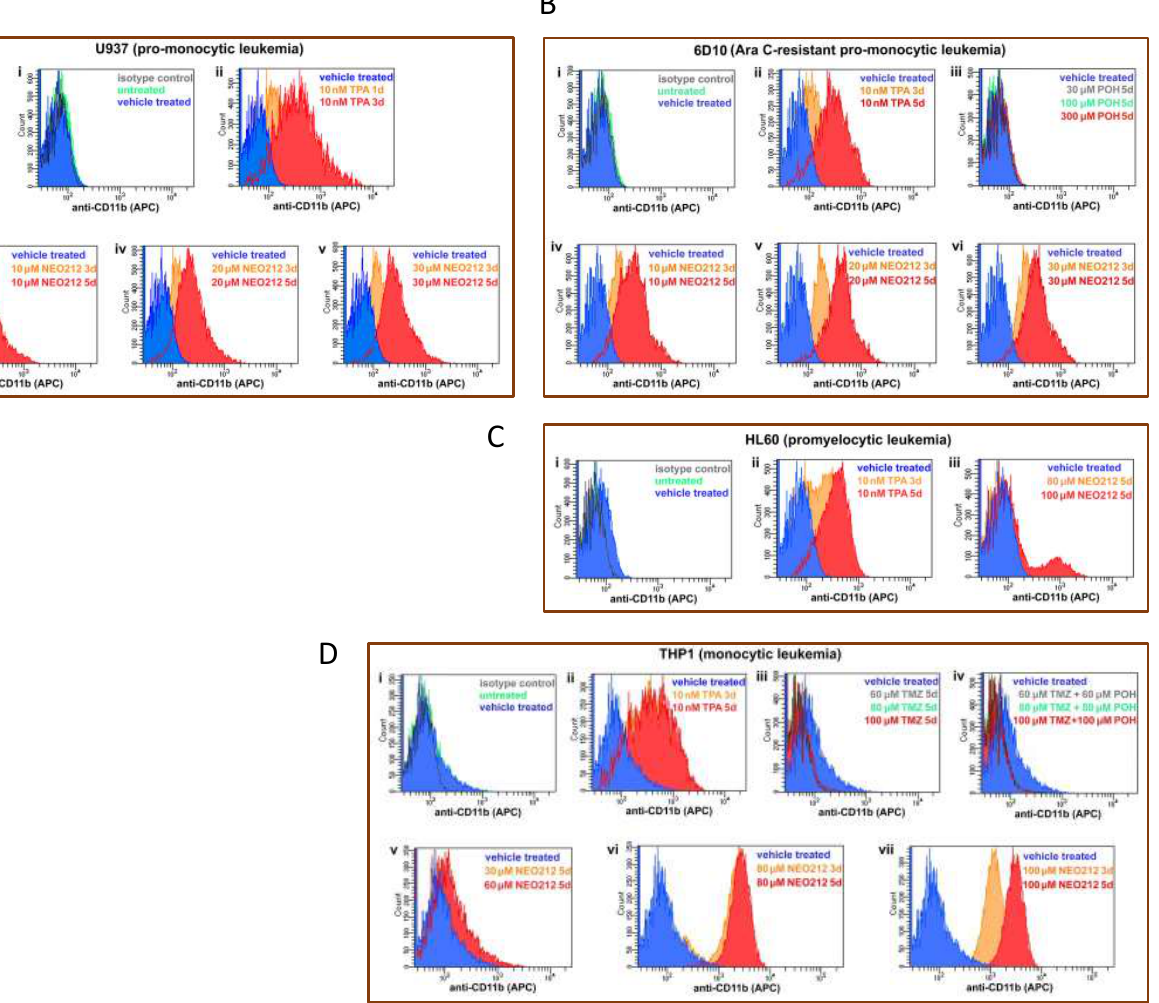
Figure 7. NEO212 stimulates cell surface presence of CD11b. AML cell lines were subjected to different treatments, followed by FACS analysis for CD11b positivity. The first square (top left, indicated with “i”) in each panel shows the following control histograms: untreated cells (green), vehicle treated cells (blue), and cells incubated with isotype control antibody (dark grey); as shown for each of the cell lines used, these negative controls showed no shift of the histograms. ( A ) U937 cells were treated with 10 nM TPA for 1 or 3 days (panel ii), or with 10, 20 and 30 µM NEO212 for 3 or 5 days (panels iii–v). ( B ) 6D10 cells were treated with TPA (ii), POH (iii), or with NEO212 (iv–vi). ( C ) HL60 cells were treated with TPA (ii) or with NEO212 (iii). ( D ) THP1 cells were treated with TPA (ii), TMZ (iii), TMZ combined with POH (iv), or with NEO212 (v–vii).